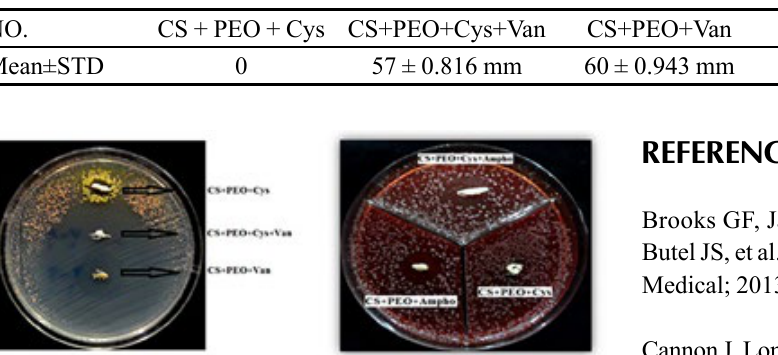
FIGURE 9 - The antibacterial and anti-fungal effect of the drug- loaded